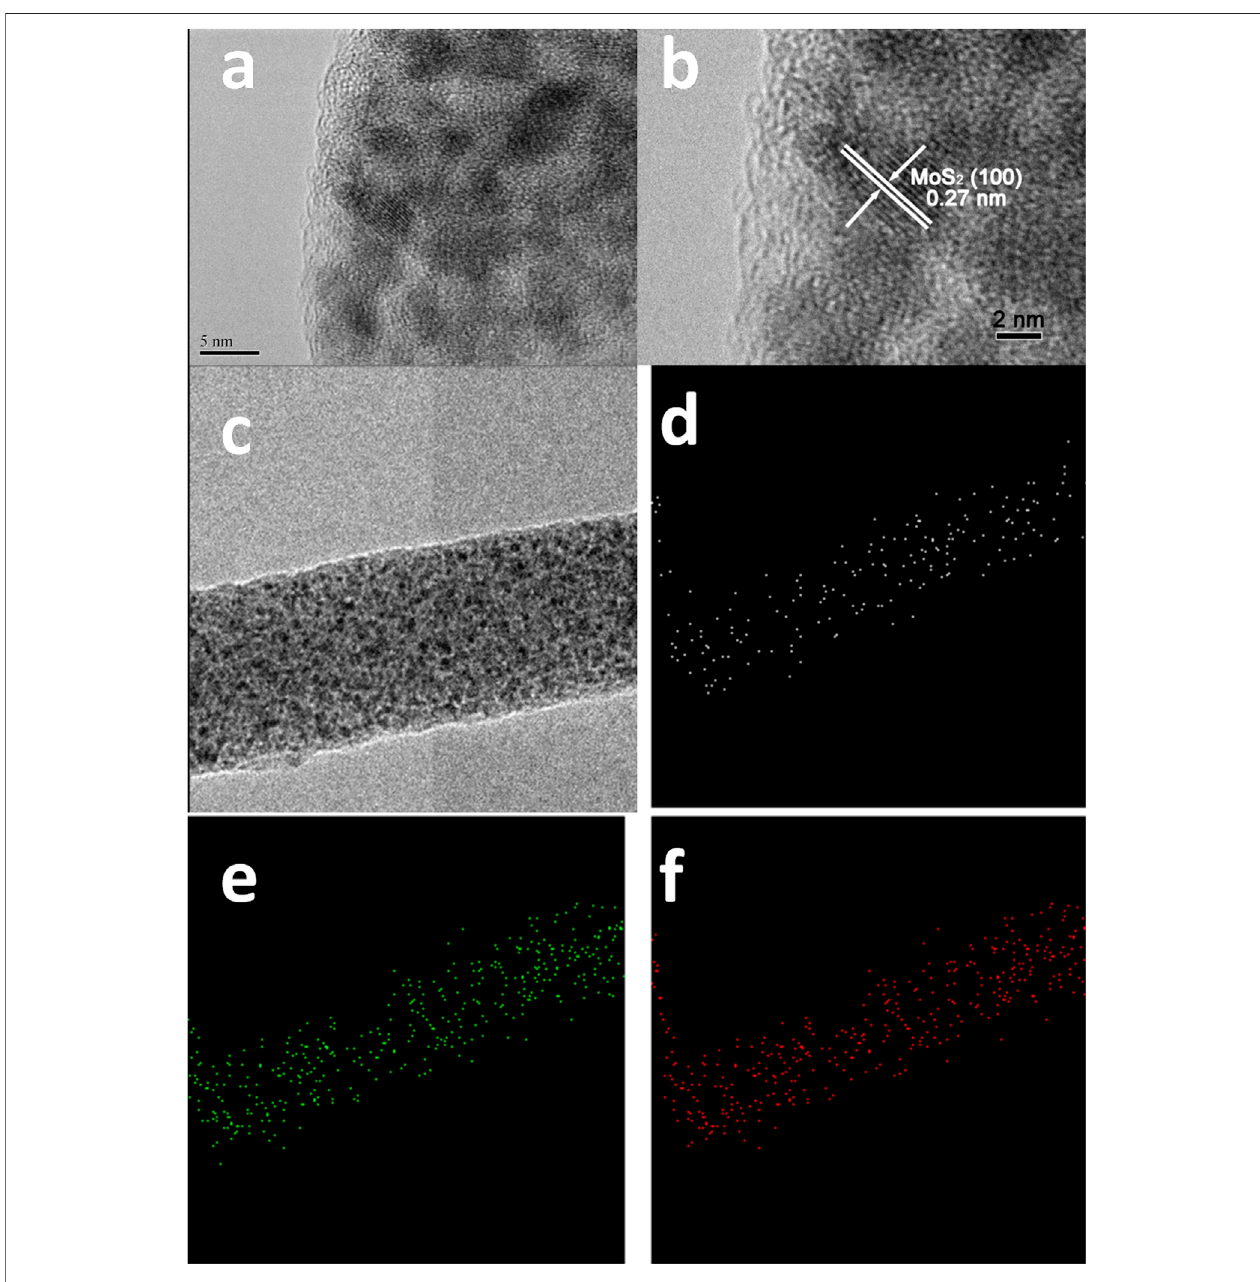
FIGURE 3 | High-magni fi cation transmission electron microscope images of (A) ; (B) air-mesoporous silica nano fi ber; (C) – (F) element mapping of air-mesoporous silica nano fi ber; the white points in (D) for C; the green points in (E) for S; the red points in (F) for Mo.